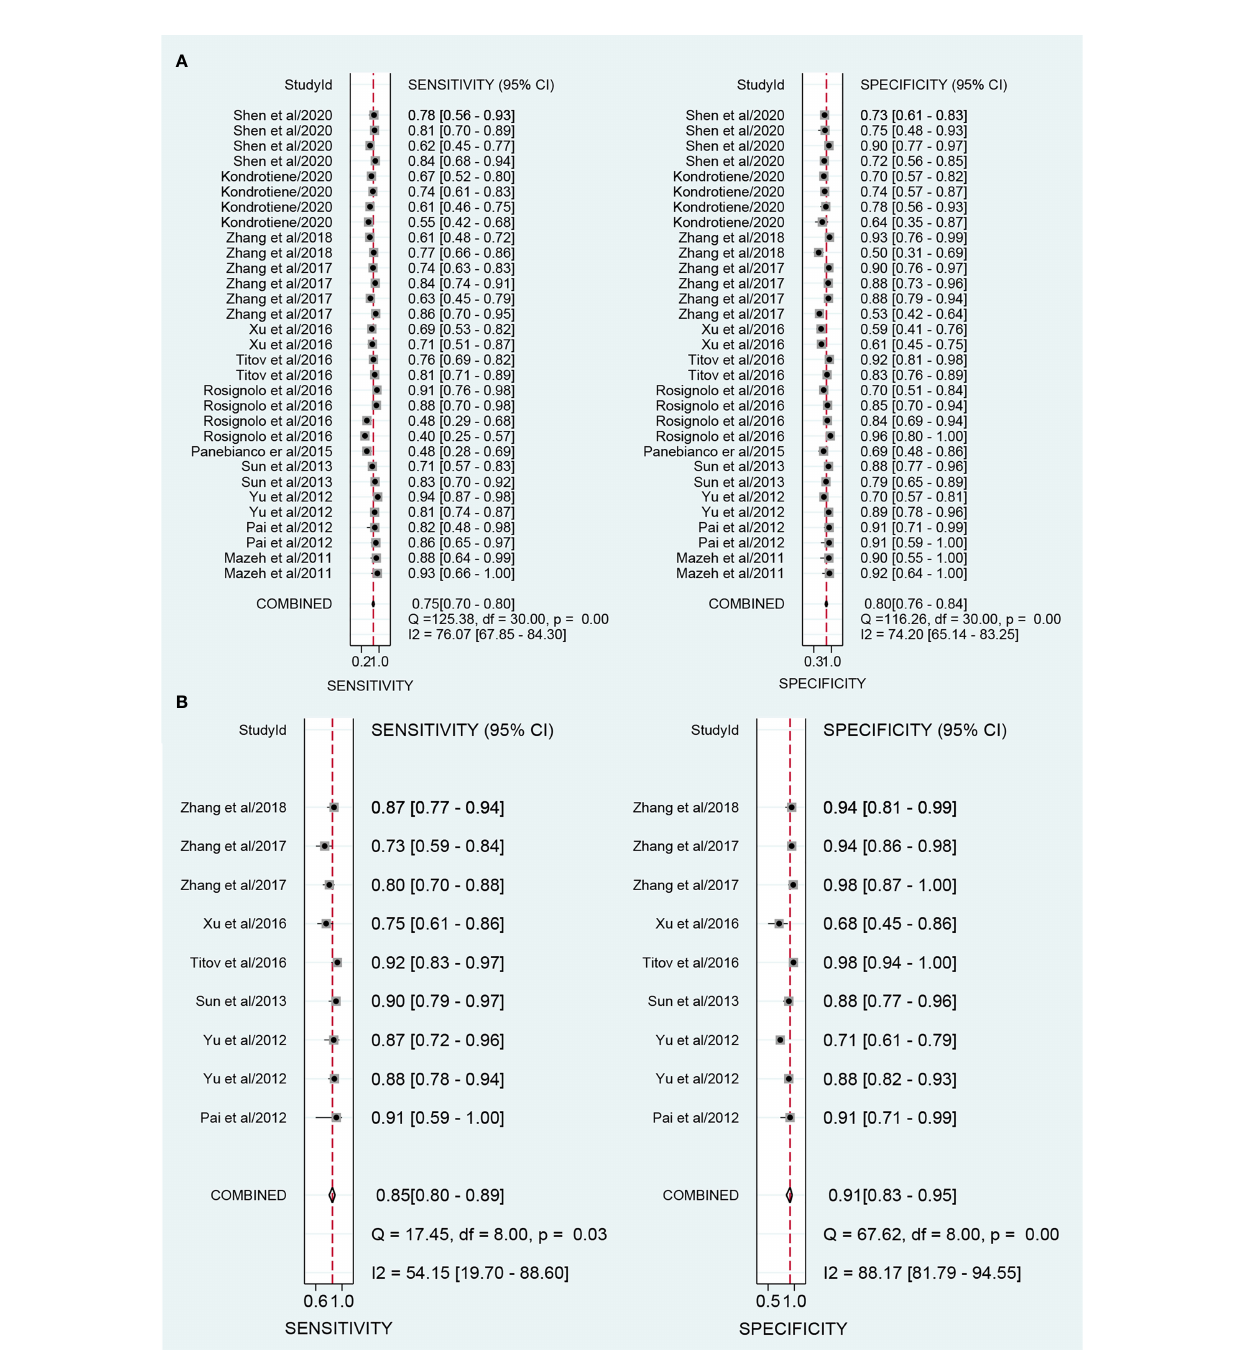
FIGURE 2 | Forest plots of sensitivity and speci fi city for the distinguishing of papillary thyroid carcinoma (PTC) and controls. (A) Forest plots for using one of miR- 221/222 in the diagnosis of PTC; (B) Forest plots for combination biomarkers containing both miR-221/222 in the diagnosis of